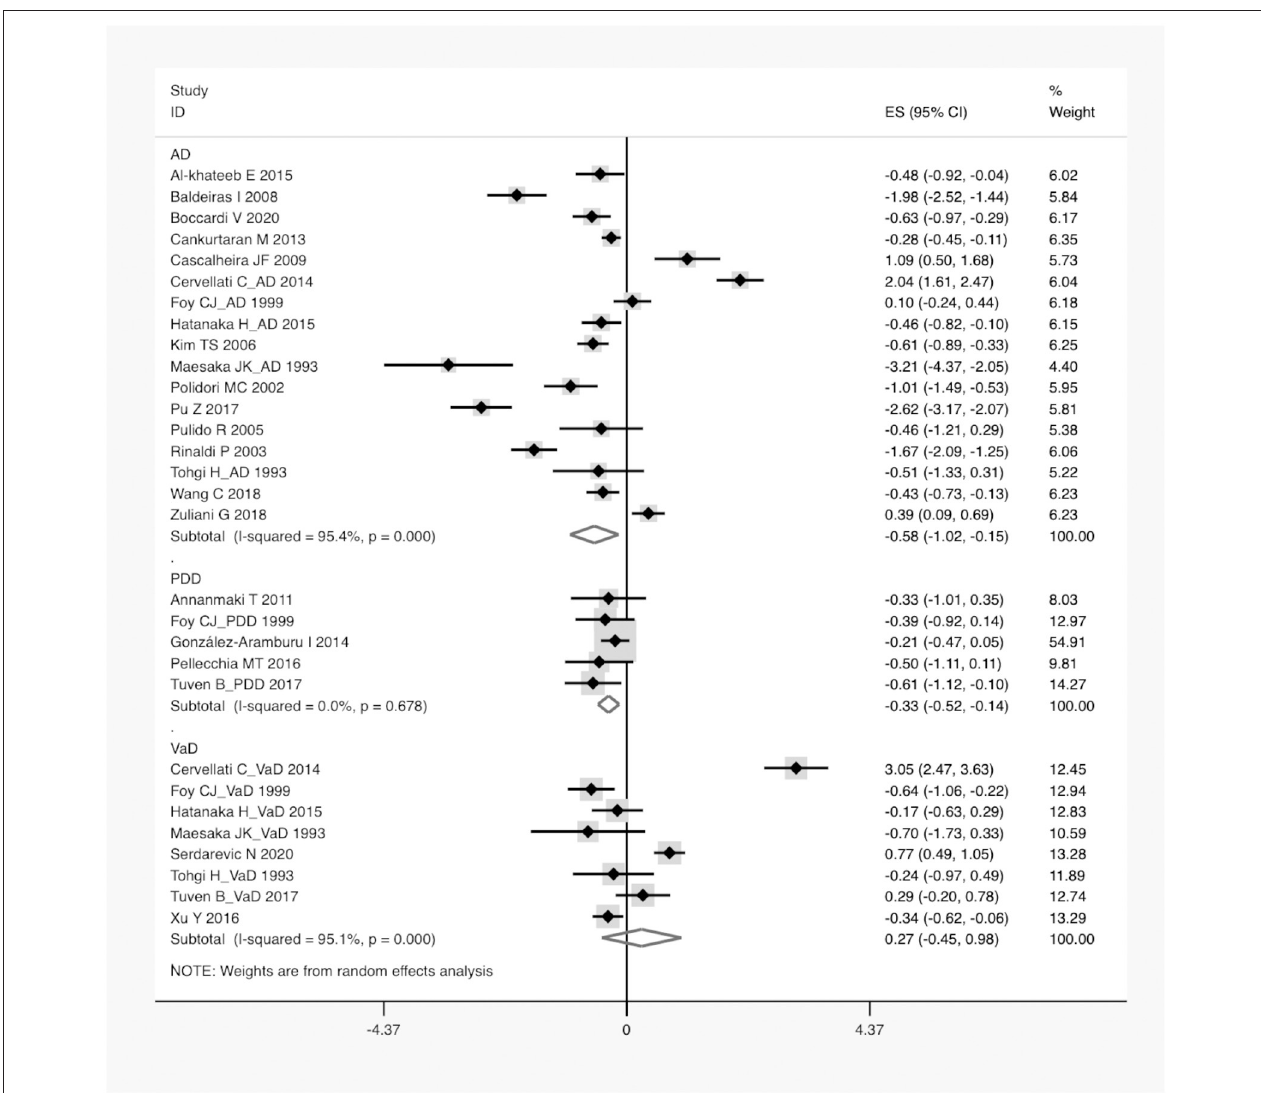
FIGURE 3 | A forest plot of the subgroup analysis on the type of dementia in UA between dementia and non-dementia. AD, Alzheimer’s disease; PDD, Parkinson’s disease with dementia; VaD, vascular dementia; ES, effect size; CI, confidence interval; UA, uric acid.